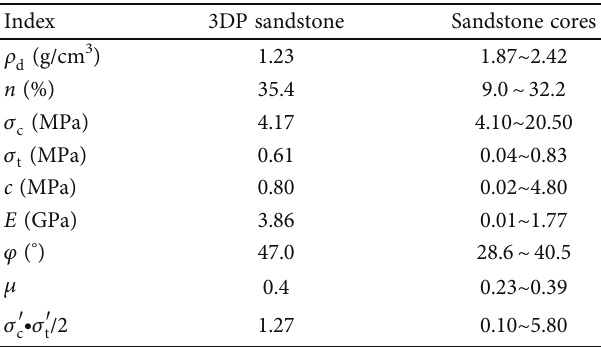
Table 3: Comparisons between Cretaceous sandstone cores and 3DP sandstones.